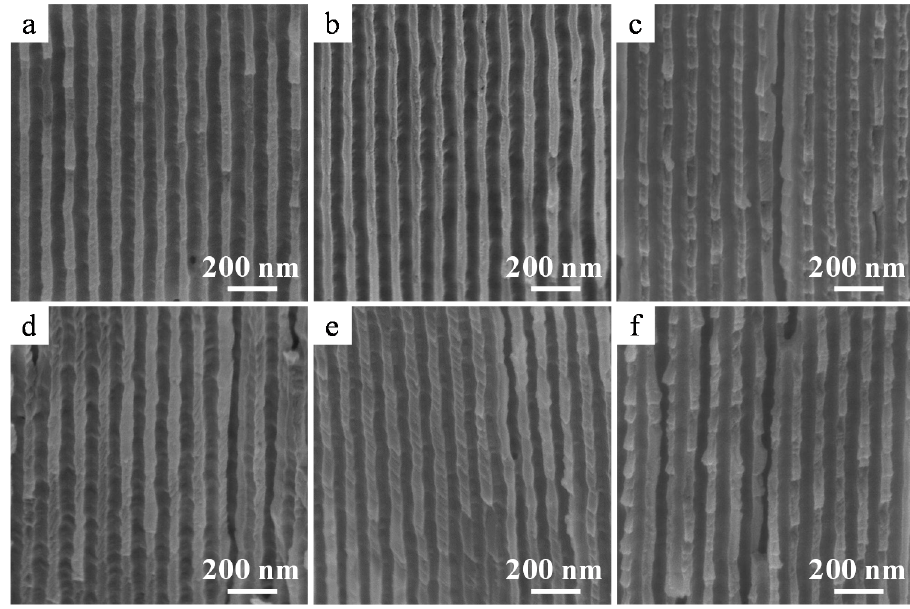
Figure 8. Cross-sectional SEM images of α -alumina membranes formed in 0.3 mol·dm − 3 oxalic acid at 40 V after chemical resistance tests. ( a ) As-heated at 1250 °C for 4 h and after immersion in ( b ) concentrated H 2 SO 4 ; ( c ) concentrated H 3 PO 4 ; ( d ) 10 mol·dm − 3 KOH; ( e ) 10 mol·dm − 3 NaOH at room temperature for 2500 h; and ( f ) pressurized water vapor